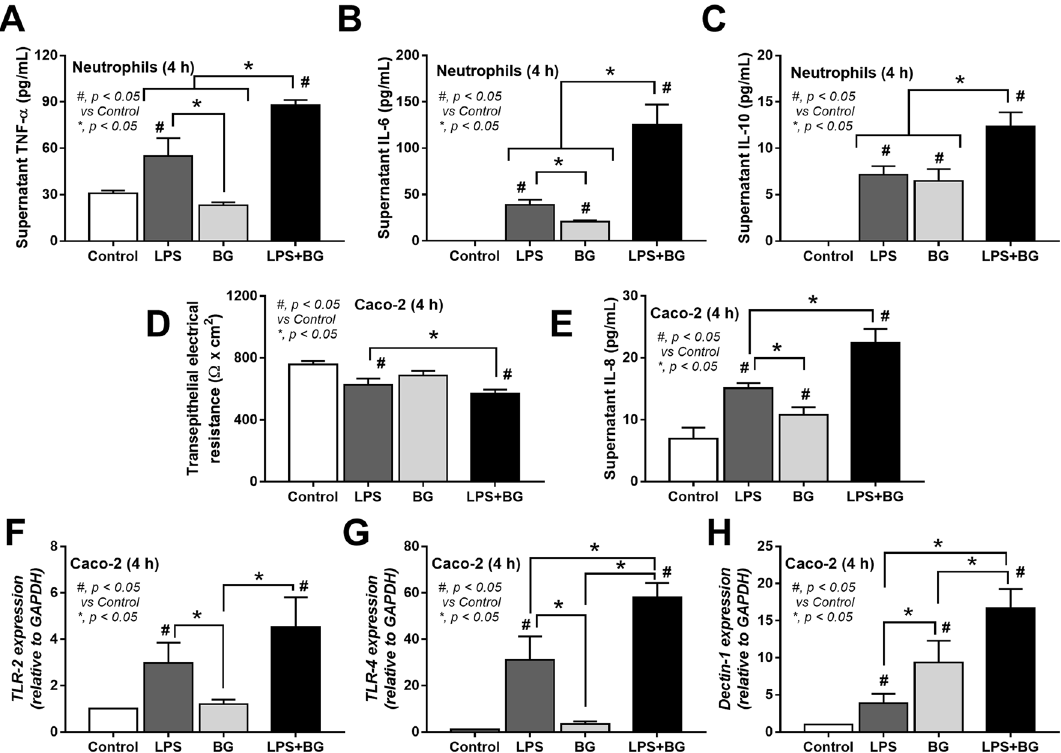
Figure 10. Characteristics of cells after incubation with media control (control), lipopolysaccharide (LPS), (1 → 3)-β-d-glucan (BG) or LPS with BG (LPS + BG) as indicated by supernatant cytokines (TNF-α, IL-6 and IL-10) from human neutrophils ( A – C ), the injury of intestinal cells (Caco-2 cells) using transepithelial electrical resistance (TEER) and supernatant IL-8 ( D , E ) are demonstrated (independent triplicated experiments were performed), and stimulated Caco-2 cells was determined genes expression including TLR-2, TLR-4, and Dectin-1 ( F – H